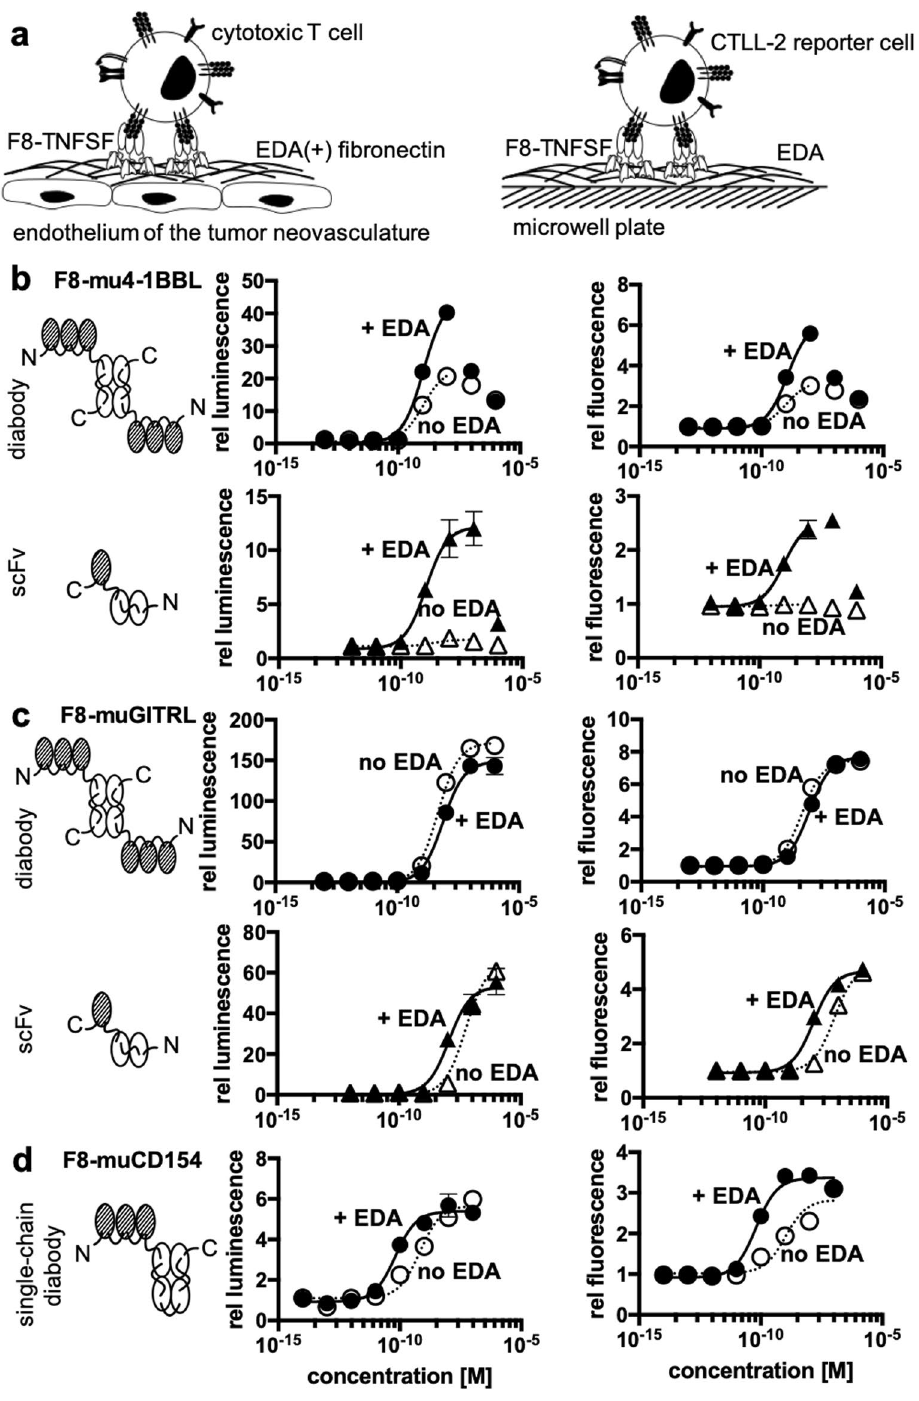
Figure 4. Clustering of cytokines of the TNF superfamily fused to fragments of the F8 antibody on EDA [a] In vivo the F8 antibody binds to the extradomain A (EDA) of fibronectin that is present in the tumor-associated neovasculature. This is thought to lead to clustering of the cytokine fused to the F8 antibody and therefore to enhance activation of target cells such as cytotoxic T cells. To mimic this situation in vitro , microwell plates were coated with the extradomain A of fibronectin. The activity of the immunocytokine when clustered on EDA and without clustering was compared for different formats. [ b ] activity of 4-1BBL in the single-chain trimeric format fused to the F8 antibody in the diabody format and in the monomeric format fused to the single- chain Fragment variable of F8 (scFv) [c] activity of GITRL in the single-chain trimeric format fused to the F8 antibody in the diabody format and in the monomeric format fused to the single-chain Fragment variable of F8 [ d ] activity of CD154 in the single-chain trimeric format fused to the F8 antibody in the single-chain diabody format (circles: F8 in diabody format, triangles: F8 in scFv format, filled symbols: plate coated with EDA, empty symbols, dashed line: no